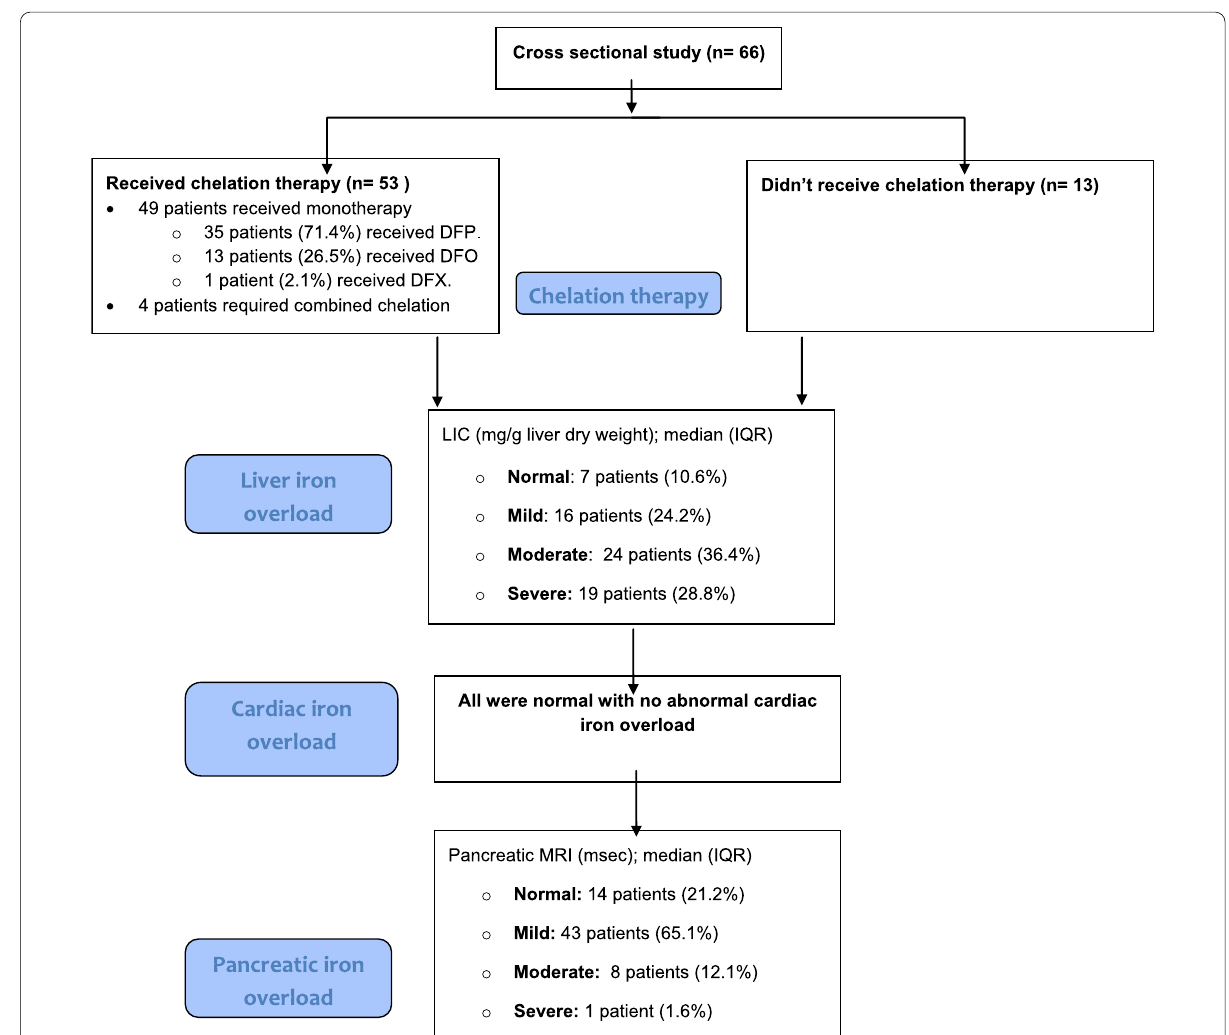
Fig. 1 Flow diagram showing the number of patients under chelation therapy, as well as the hepatic, cardiac, and pancreatic iron loading among the sample